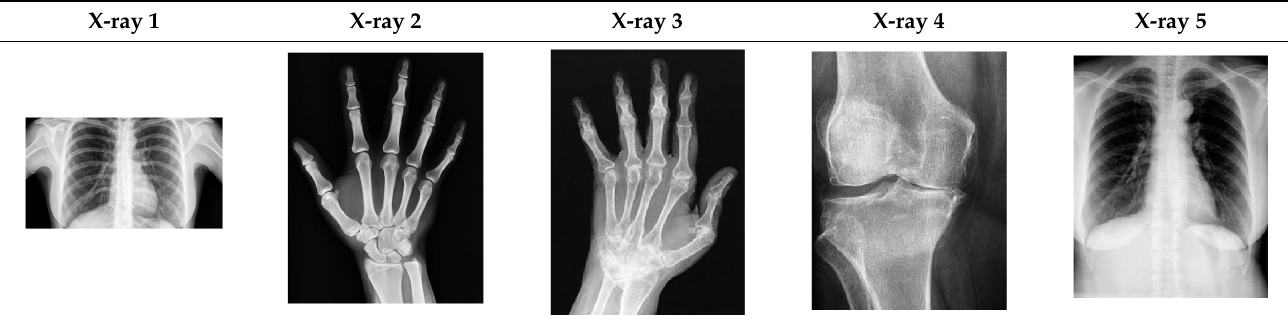
Table 5. X-ray Images.